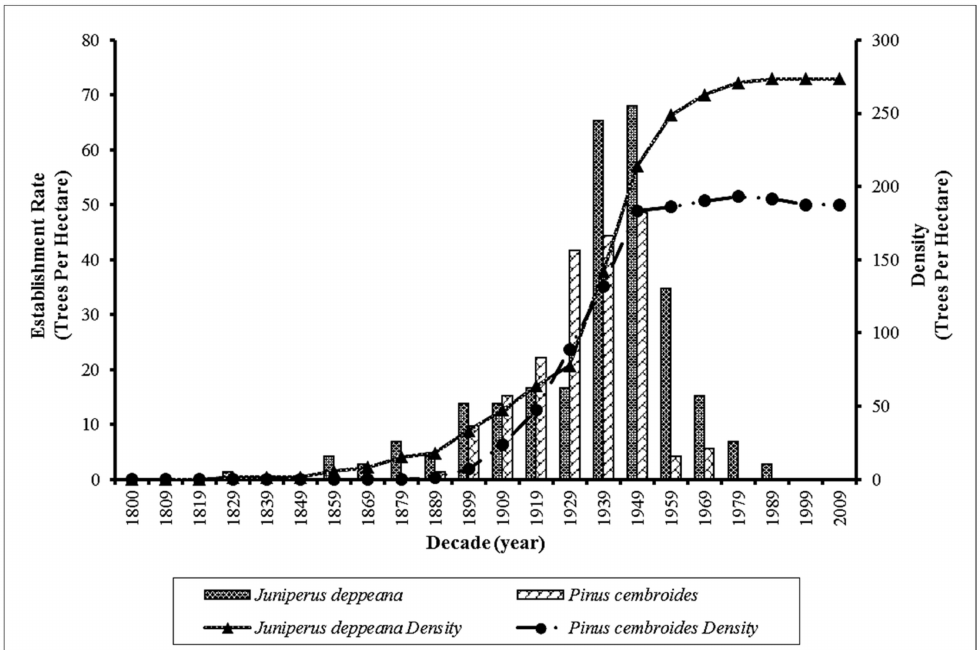
Figure 1. Establishment rates and density estimates per decade for piñon and juniper from two study sites within the Nature Conservancy Davis Mountains Preserve, Je ff erson County, Texas. Table 1. The observed, expected, R , and the Z score for contemporary and historical mean nearest neighbor distance of Mexican piñon ( Pinus cembroides var. cembroides Zucc.) and alligator juniper ( Juniperus deppeana var. deppeana Steud.) jointly and separately. Number of Observed Expected R Z Score Species Year Trees ( n ) Mean Mean